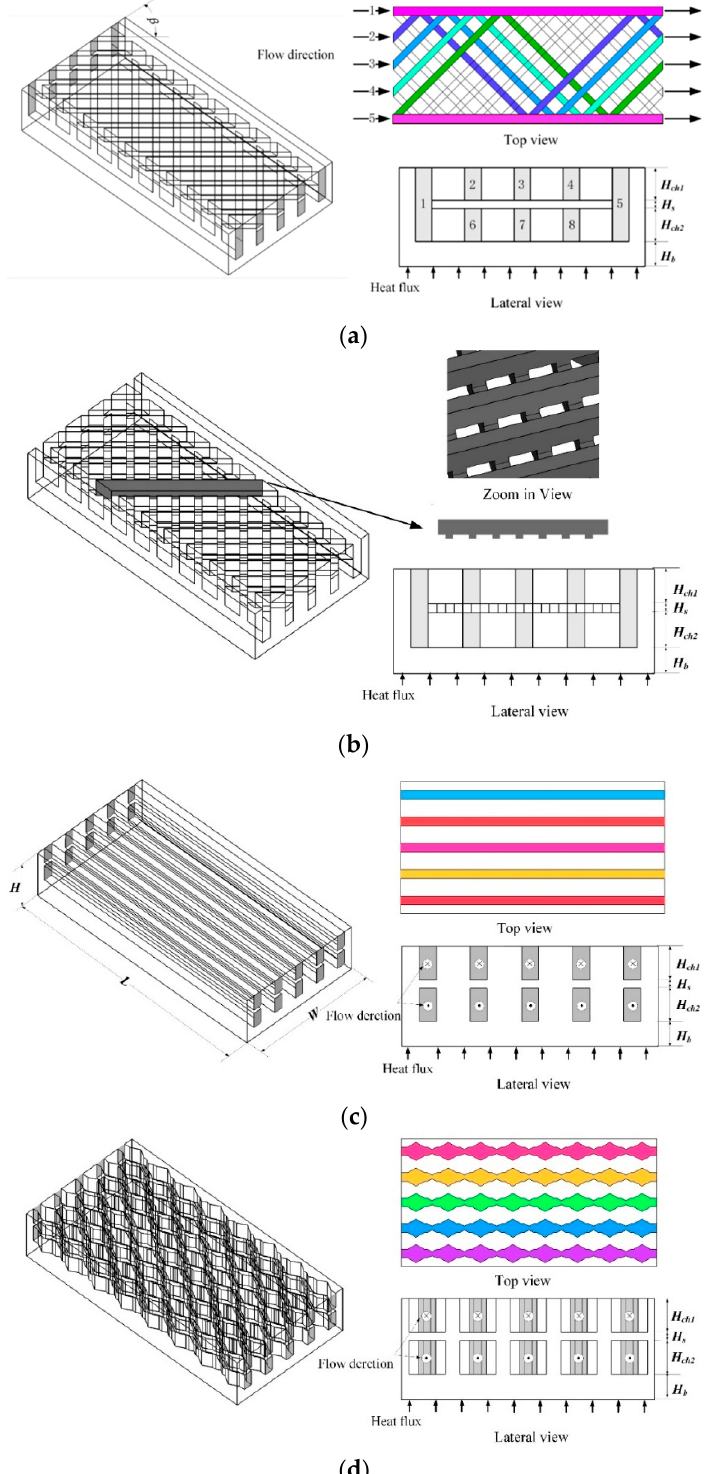
Figure 1. Schematic of four double-layered micro heat sinks: ( a ) double-layered matrix (DL-M) microchannel, ( b ) double-layered interlinked-matrix (DL-IM) microchannels, ( c ) double-layered microchannel with rectangular cross-section (DL-R), and ( d ) double-layered microchannel with triangular ribs and triangular cavities (DL-T).